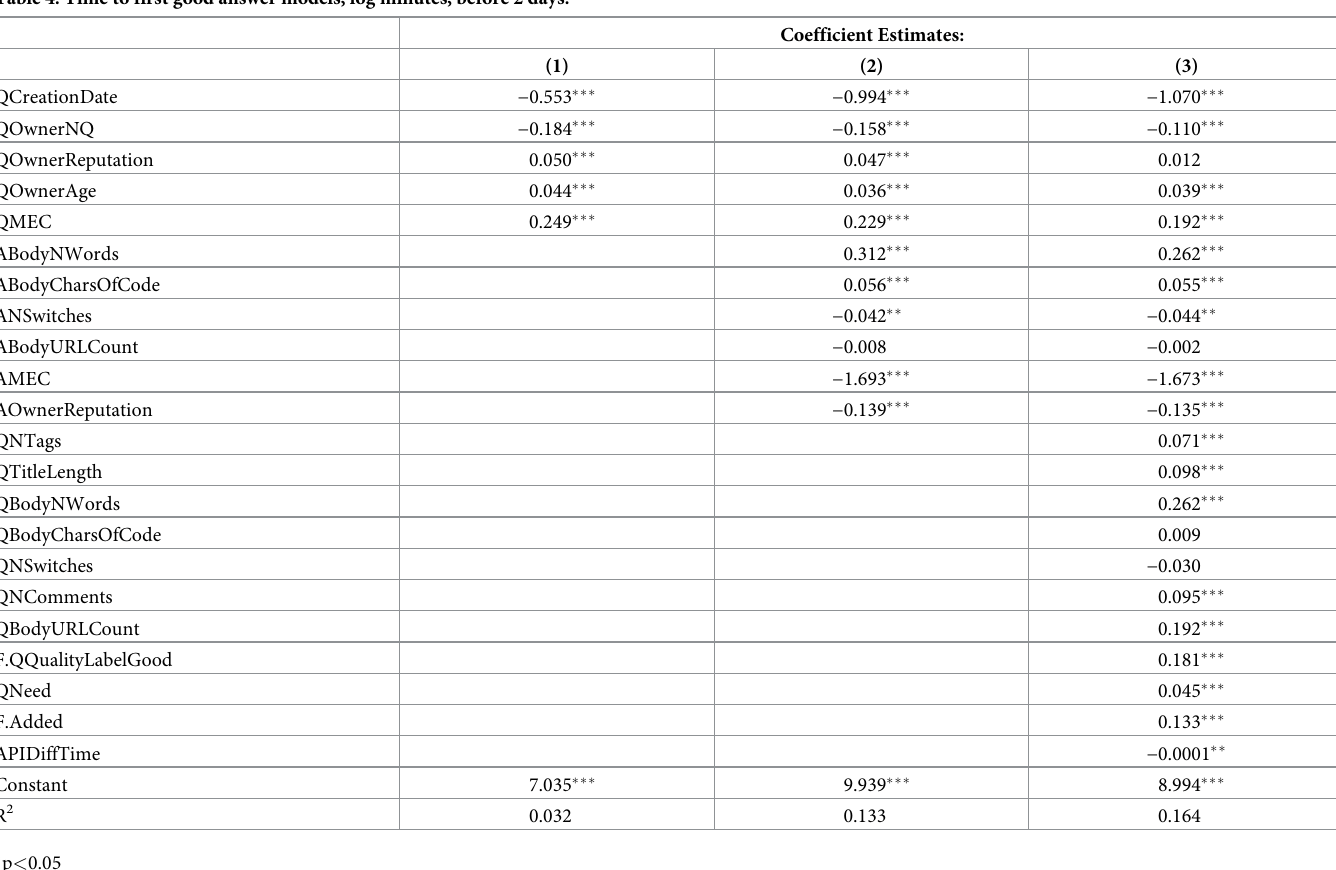
Table 4. Time to first good answer models, log minutes, before 2